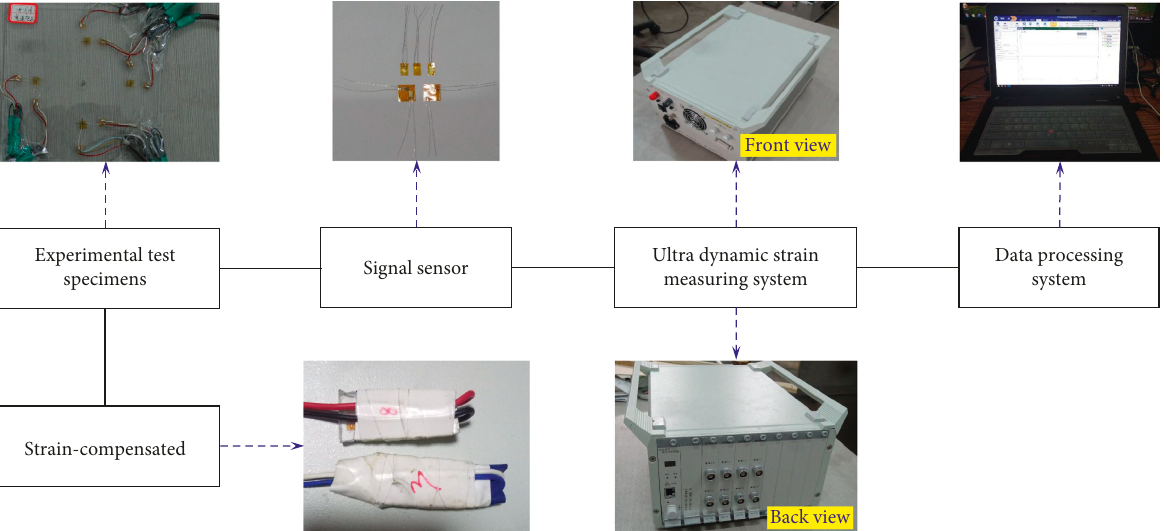
Figure 2: Diagram of test system connection.